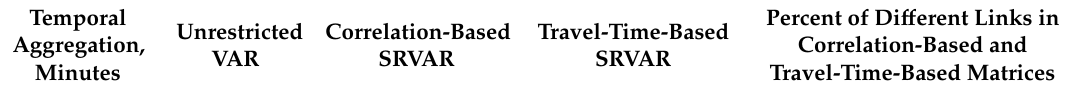
Table 2. Number of links and similarity of spatial dependency